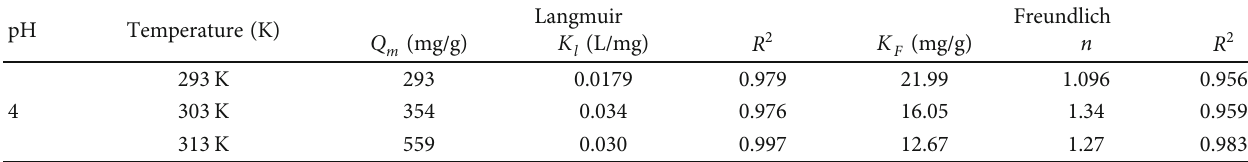
Table 3: Isotherm pseudo parameters.